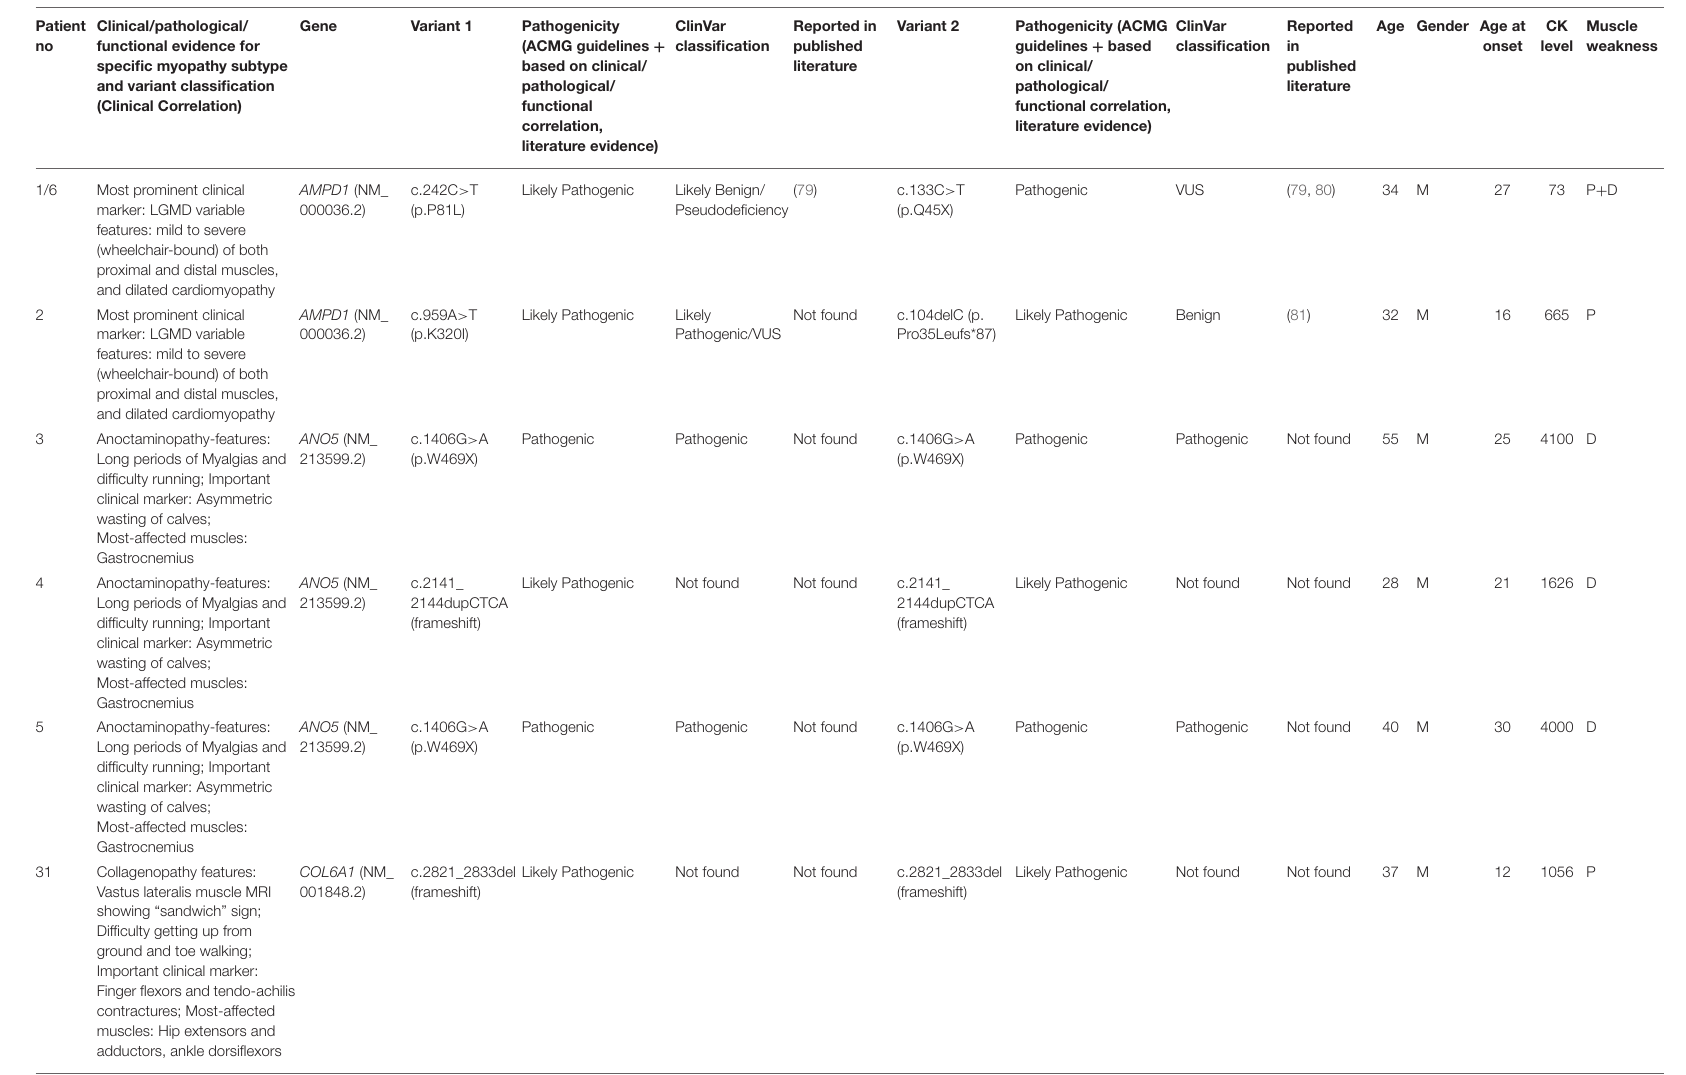
TABLE 3 | Uncommon subtypes identified in Indian patients. Patient Clinical/pathological/ no functional evidence for specific myopathy subtype and variant classification (Clinical Correlation)